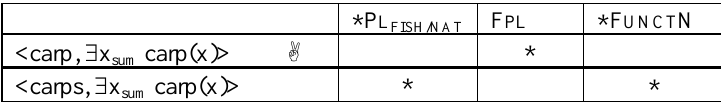
Tableau V: unmarked plural in